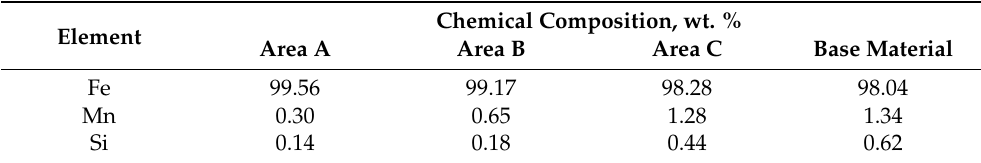
Table 2. Average values of elements content in EDS analysis for the base material and areas A, B, C shown in Figure 3. Chemical Composition, wt. Element